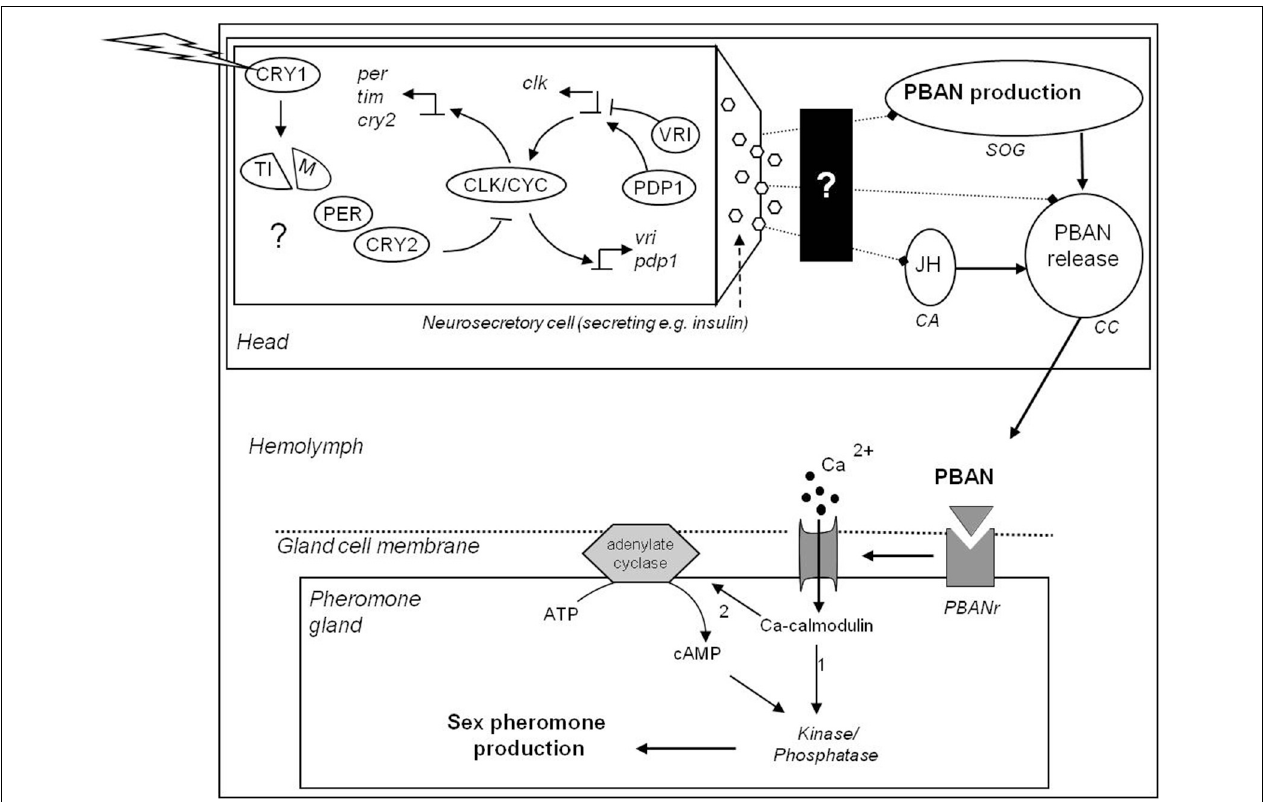
FIGURE 1 | Simplified flow diagram of circadian feedback loops in neurosecretory cells and their possible regulation of moth sex pheromone biosynthesis. Question marks are the outstanding questions for moths. Clock genes are expressed in neurosecretory cells [pars lateralis (PL) and pars intercerebralis (PI)], but maybe also in the subesophagal ganglion (SOG), corpus cardiacum (CC) and corpus allatum (CA) (see Sandrelli et al., 2008). CRY1 is activated by light and degrades TIM. CRY2 is light-independent and inhibits CLK/CYC mediated expression of per/tim . In both day-active and night-active insects, per and tim are transcribed mostly at night. The neurosecretory cells innervate the CA, CC and/or the SOG (indicated with dotted lines with diamond) (Bloch et al., 2013), activating JH production in CA. Exactly how this activation occurs is still a black box, although it is known that insulin is involved (Reppert et al., 2010). PBAN is produced in the SOG, likely continuously, so that it accumulates during the photophase in some moths (Rafaeli, 1994). PBAN transport to and its release from the CC into the hemolymph is regulated